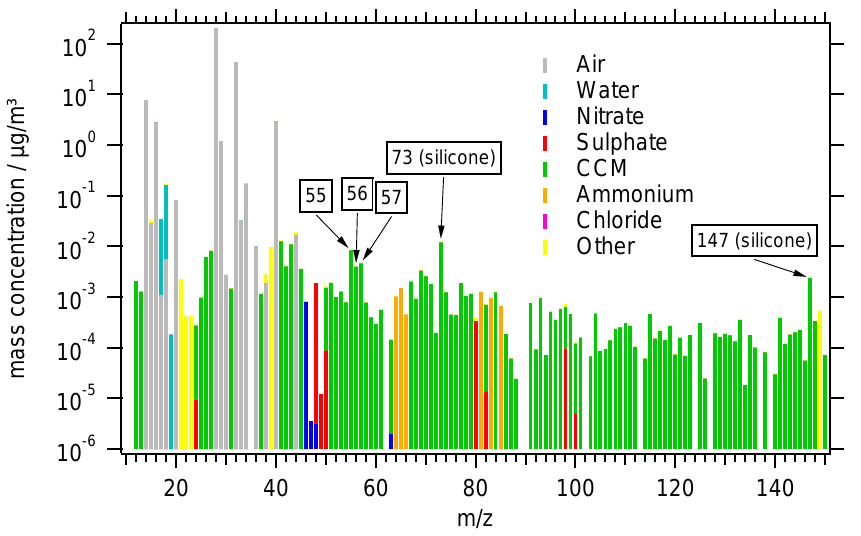
Fig. 2a. Average AMS mass spectrum for unprocessed ATD during the FROST1 campaign. The AMS vaporiser was set to 600 ◦ C. Notable are the clear peaks that can be attributed to methyl silicone contaminant.